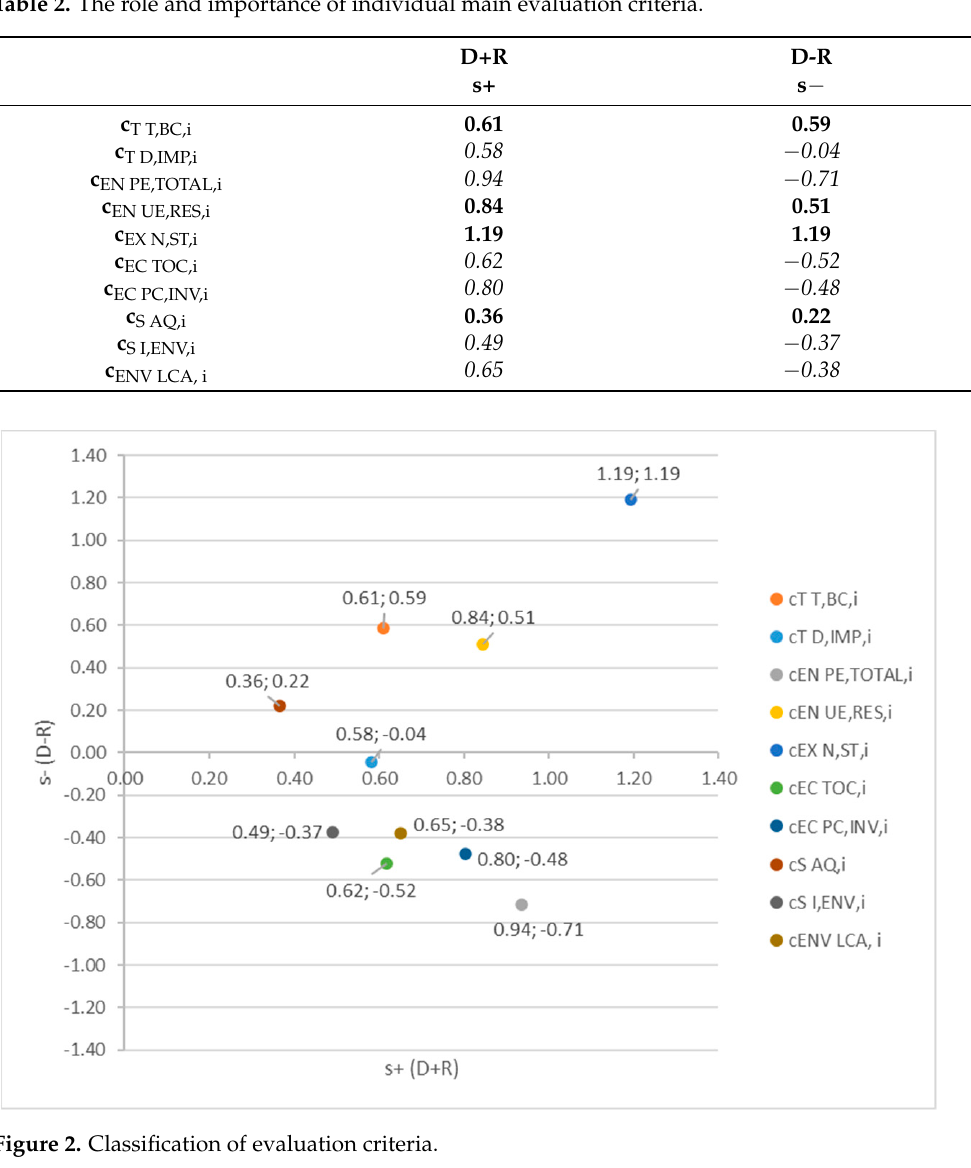
Table 3. Selected decision criteria for selecting new headquarters for the Forest Experimental Station with a positive energy balance and the weights of relations.